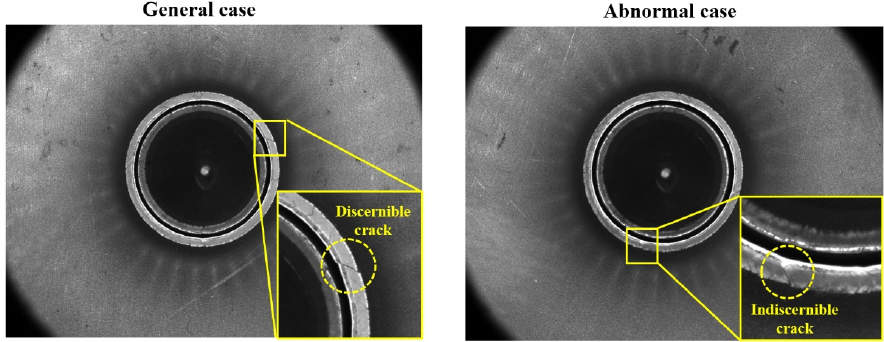
Figure 9. Cases for crack recognition by making use of machine vision analyzing system.